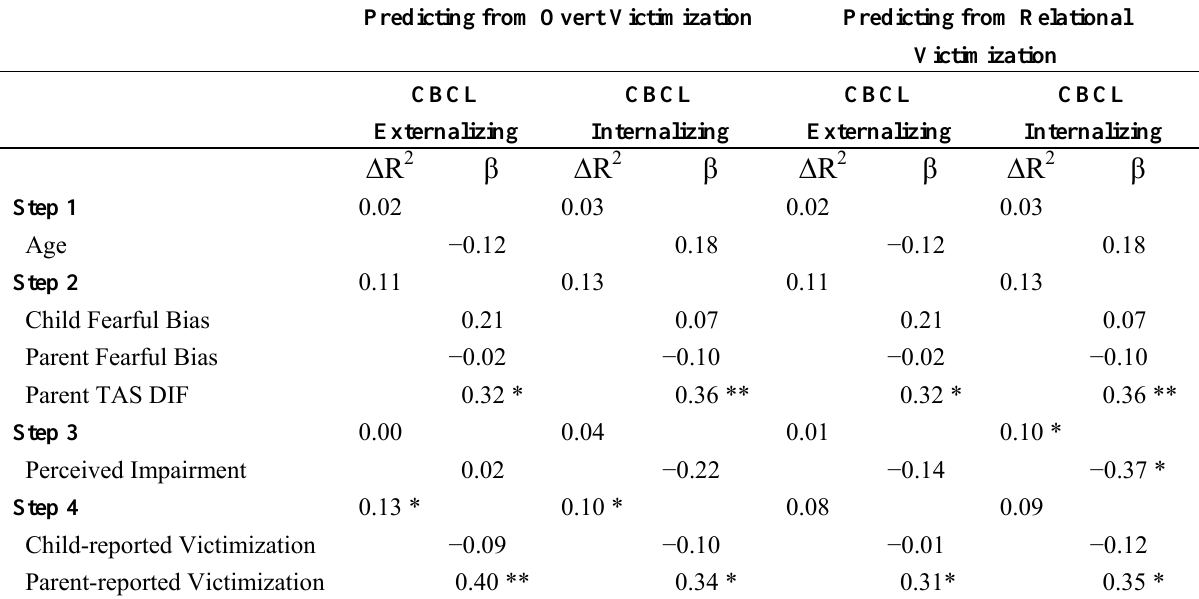
Table 5. Hierarchical Multiple Regression Analyses Predicting Child Behavior Checklist (CBCL) From Emotion Biases and